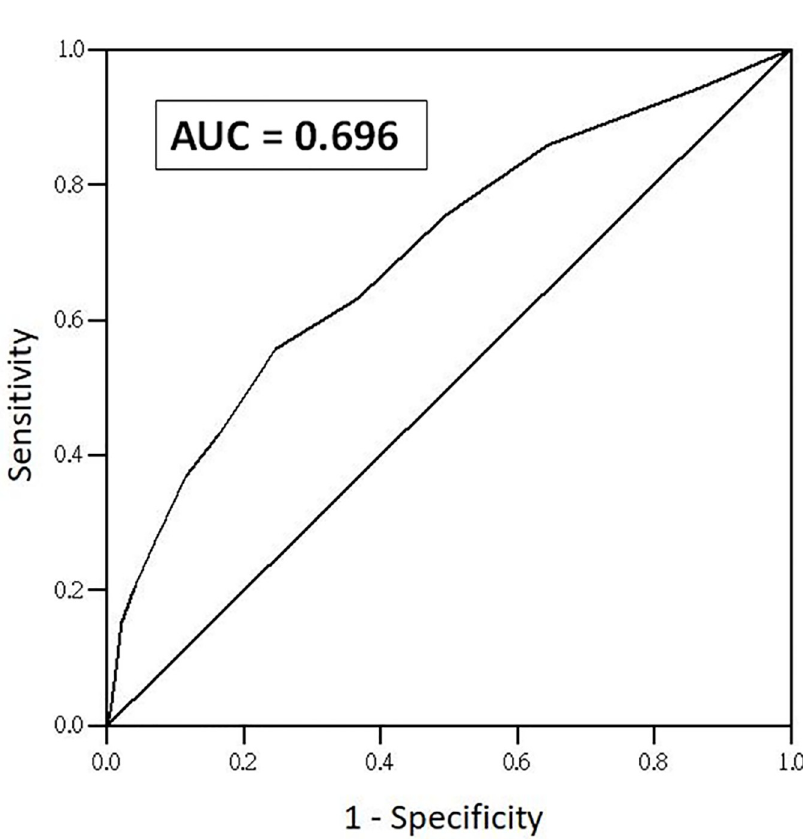
Fig 2. The AUROC for accuracy of the LRINEC score. With an LRINEC cut-off score � 8, the AUROC for accuracy of the LRINEC score was